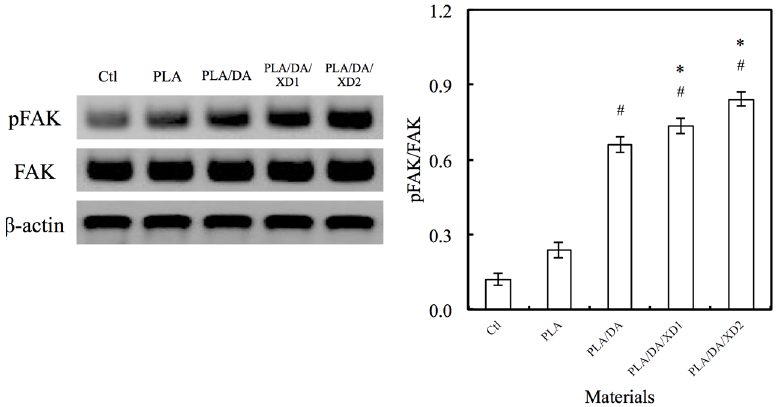
Figure 6. The morphology of hBMSCs adhered on PLA/PDA/XD scaffolds for 3 and 24 h.